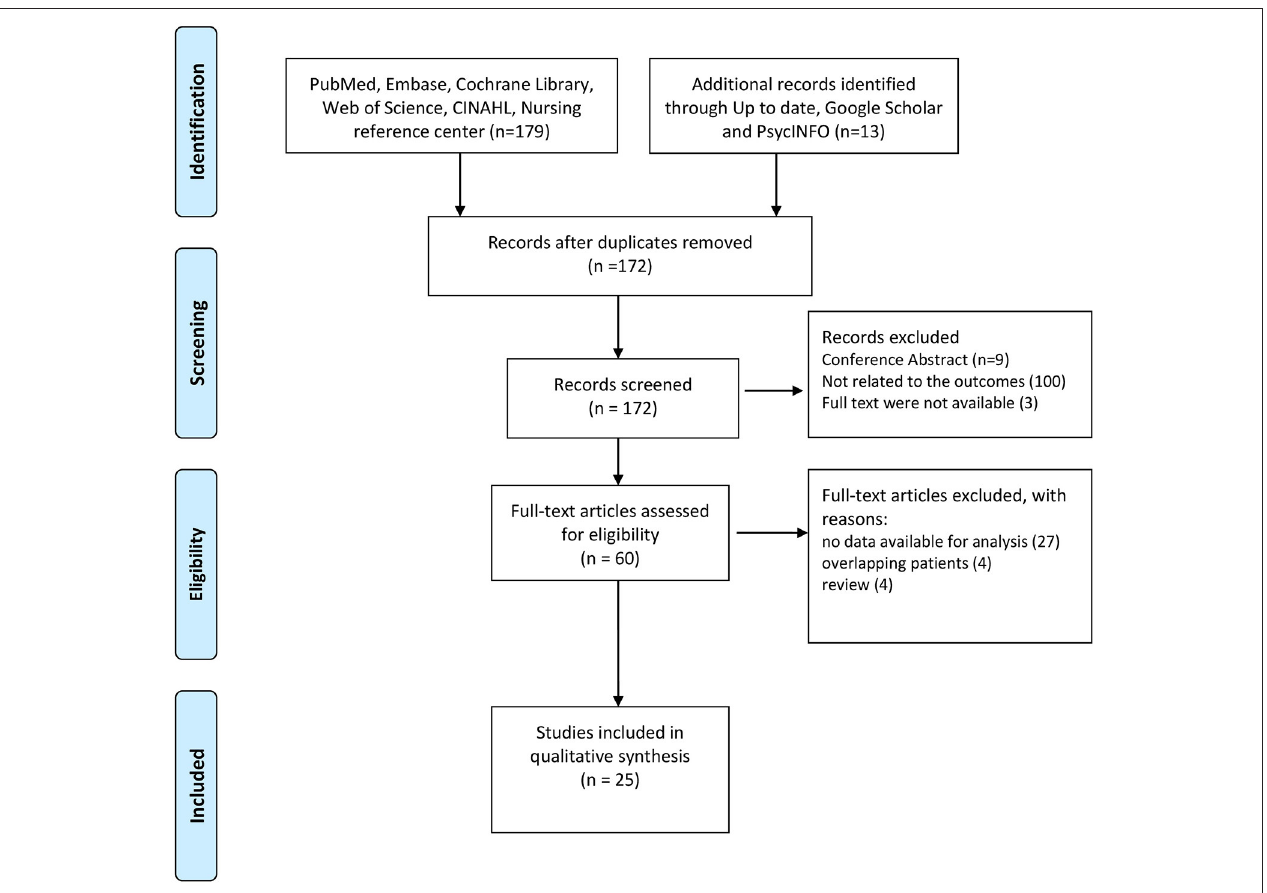
FIGURE 1 | Preferred Reporting Items for Systematic Reviews (PRISMA) flow diagram showing the progress of studies through the